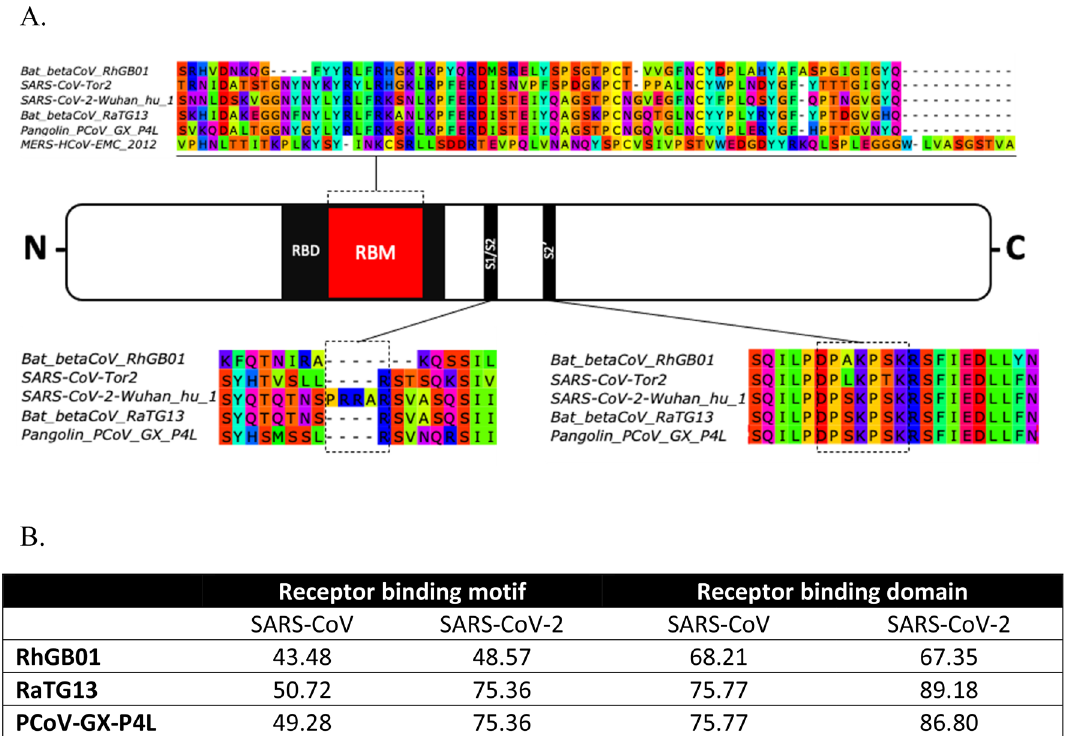
percentage identity values for the RBD and RBM regions. Amino acids are coloured according to the Taylor colour scheme. ( A ) RBM comparison demonstrates higher percentages of homology within sarbecoviruses